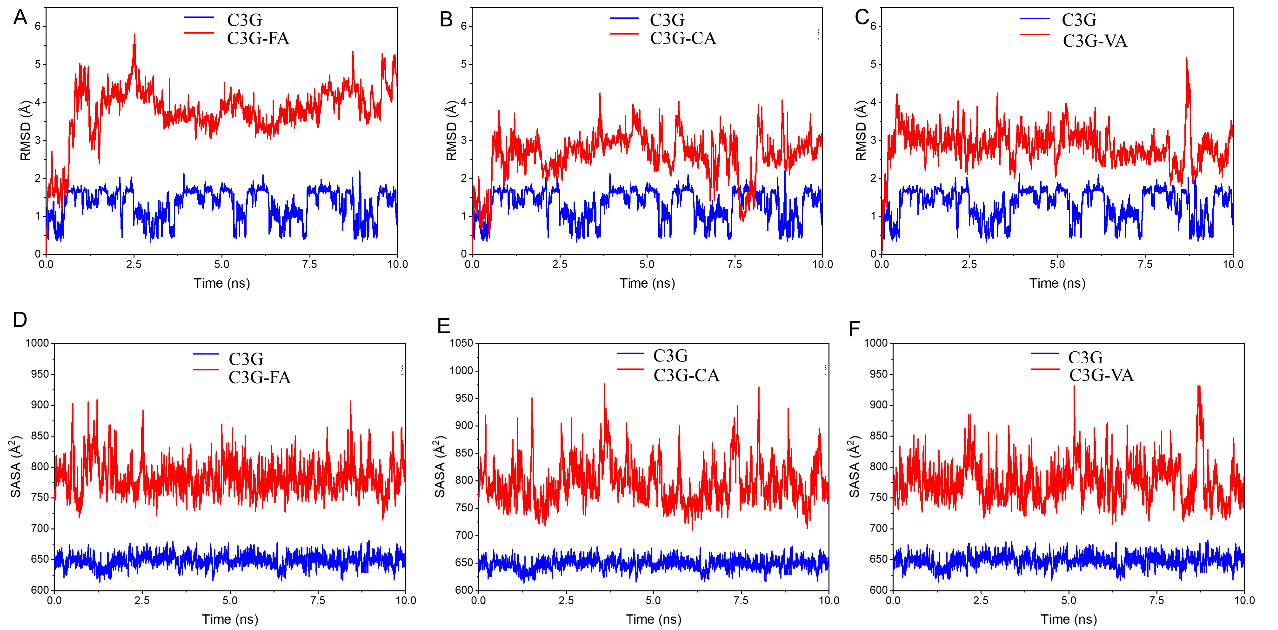
Figure 11. Changes in root mean square deviation (RMSD, ( A – C )) and solvent accessible surface area (SASA, ( D – F )) during molecular dynamic simulations.